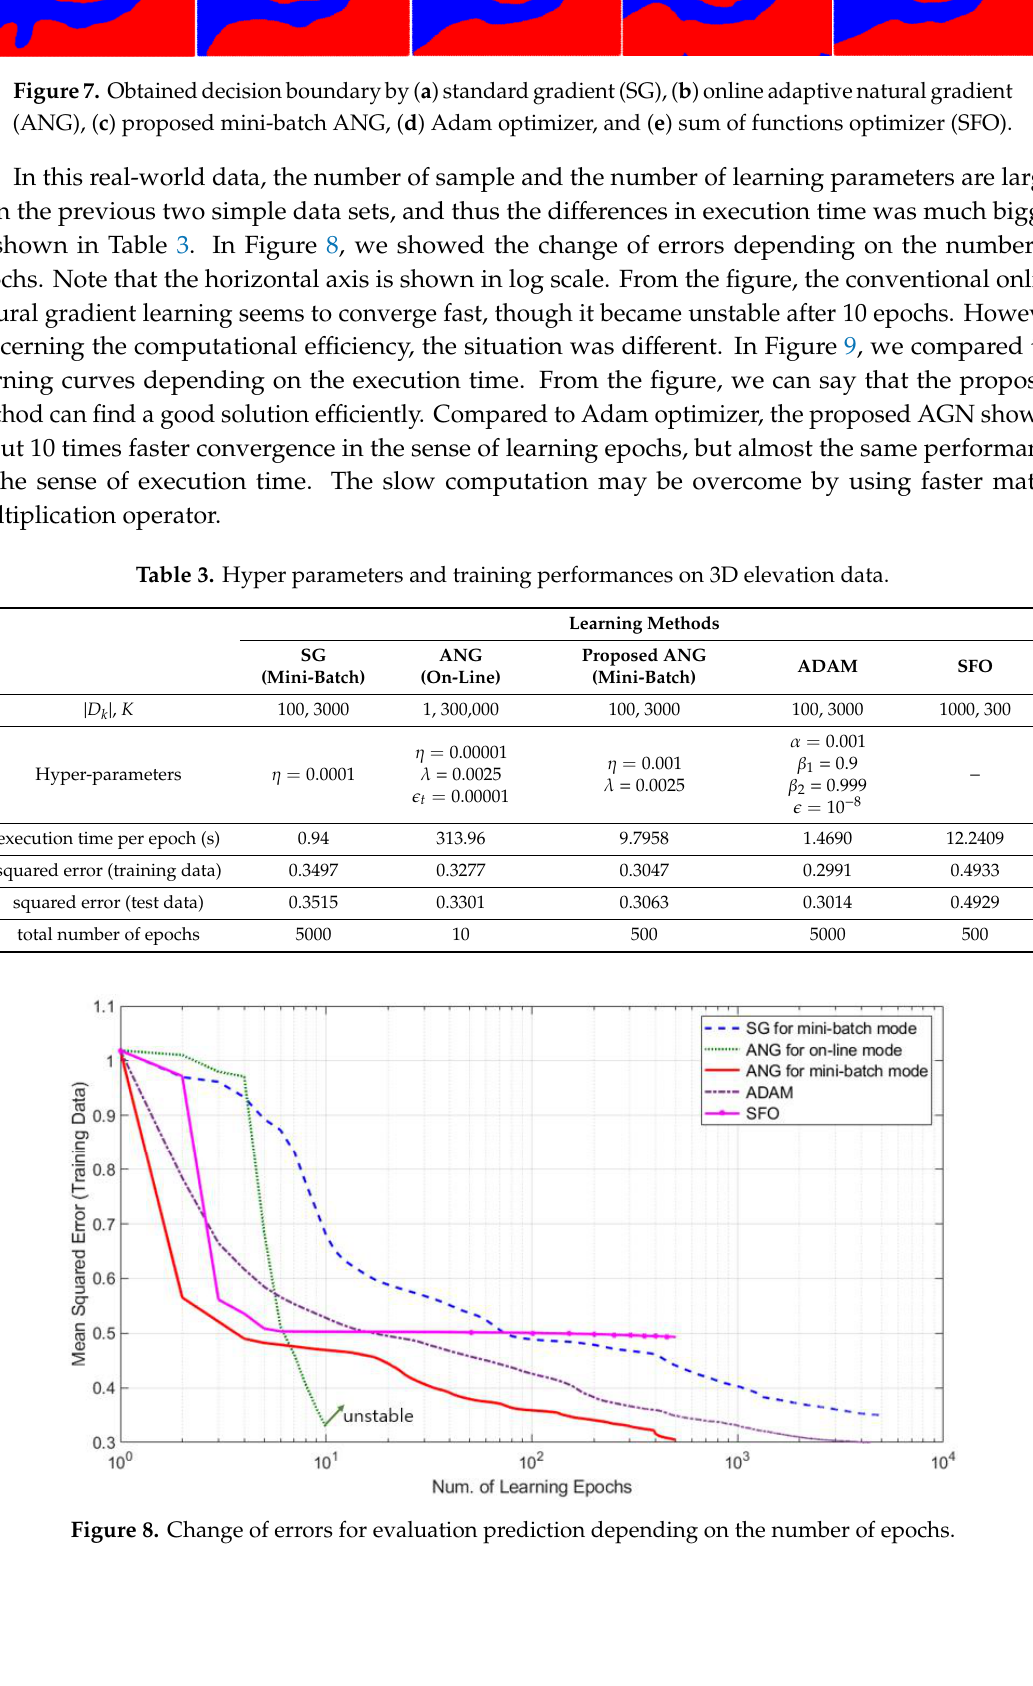
Figure 9. Change of errors for evaluation prediction depending on the execution time. 6. Conclusions In spite of remarkable developments of deep learning technologies, there is no alternative to gradient-based learning method. The strange learning behaviors of gradient descent learning, such as plateau, local minima, and low generalization error of over-complete models, have not been thoroughly investigated, and the resolution of local minima and plateau problems are still not being fully addressed. Though the original natural gradient has ideal convergence properties eliminating plateau phenomena, heavy computational cost for obtaining the inverse of Fisher information matrix makes the natural gradient unfeasible in real application. As a novel attempt to solve this practical constraint, this paper proposed an explicit and practically implementable algorithm of natural gradient method in mini-batch learning mode. By utilizing mini-batch subsets, we can get computational efficiency as well as estimation stability. In particular, we presented the explicit learning algorithm for two representative stochastic neural network models. Theoretically, the proposed algorithm does not assume the specific shape of network, and thus is applicable to any types of neural network models trained by gradient descent methods, such as convolutional neural networks and recurrent neural networks. Nevertheless, concerning